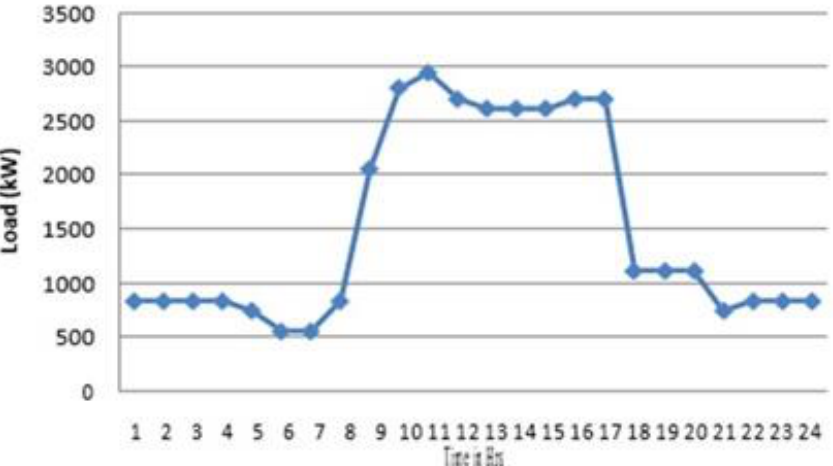
Figure 6. Electrical dispatch with the base case.